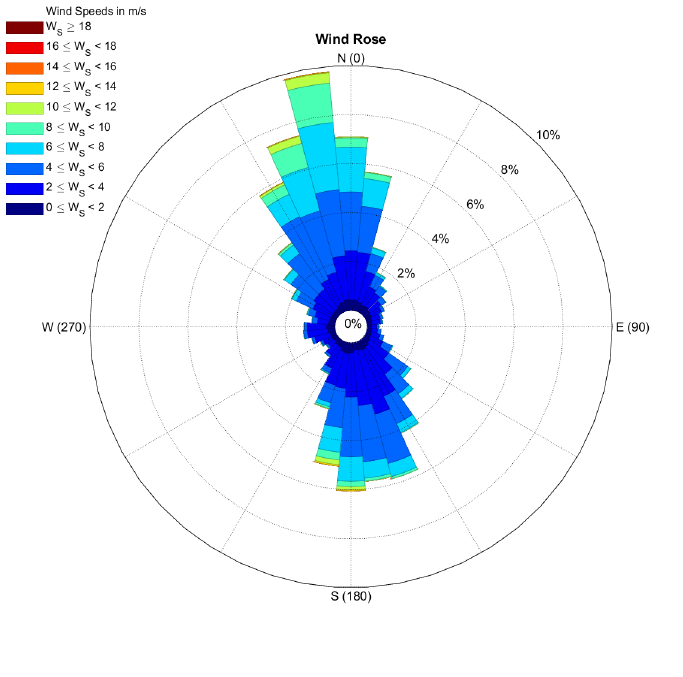
Figure 5. Long-term wind rose of Lichtenegg test